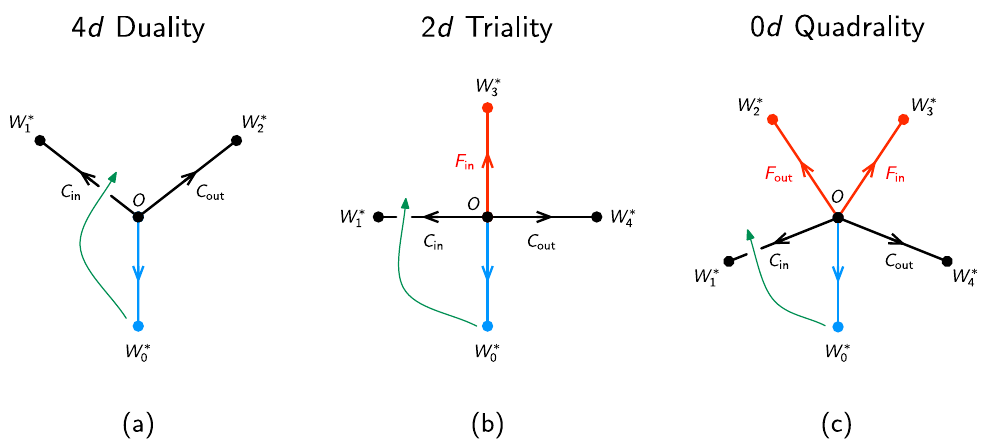
Figure 4 . Uni(cid:12)ed description of QFT equivalences in various dimensions. Mirror symmetry uni(cid:12)es them in terms of the same type of